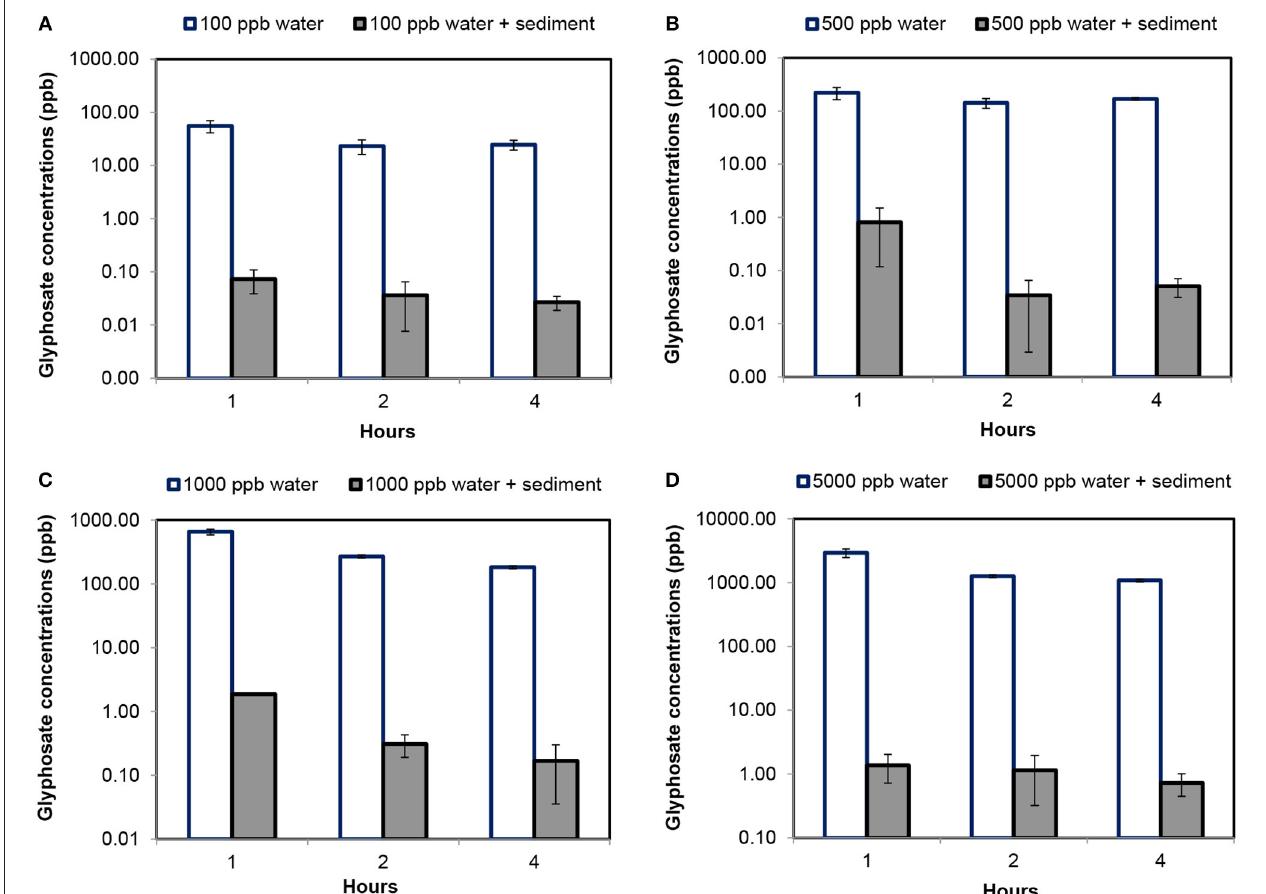
FIGURE 2 | Glyphosate concentrations determined in water and sediment feedstock after consecutive washes. (A) Determination of Glyphosate concentrations in water and sediment environment at initial concentrations of 100 ppb; (B) Determination of Glyphosate concentrations in water and sediment environment at initial concentrations of 500 ppb; (C) Determination of Glyphosate concentrations in water and sediment environment at initial concentrations of 1,000 ppb; and (D) Determination of Glyphosate concentrations in water and sediment environment at initial concentrations of 5,000 ppb [error bars indicate standard deviation of 3